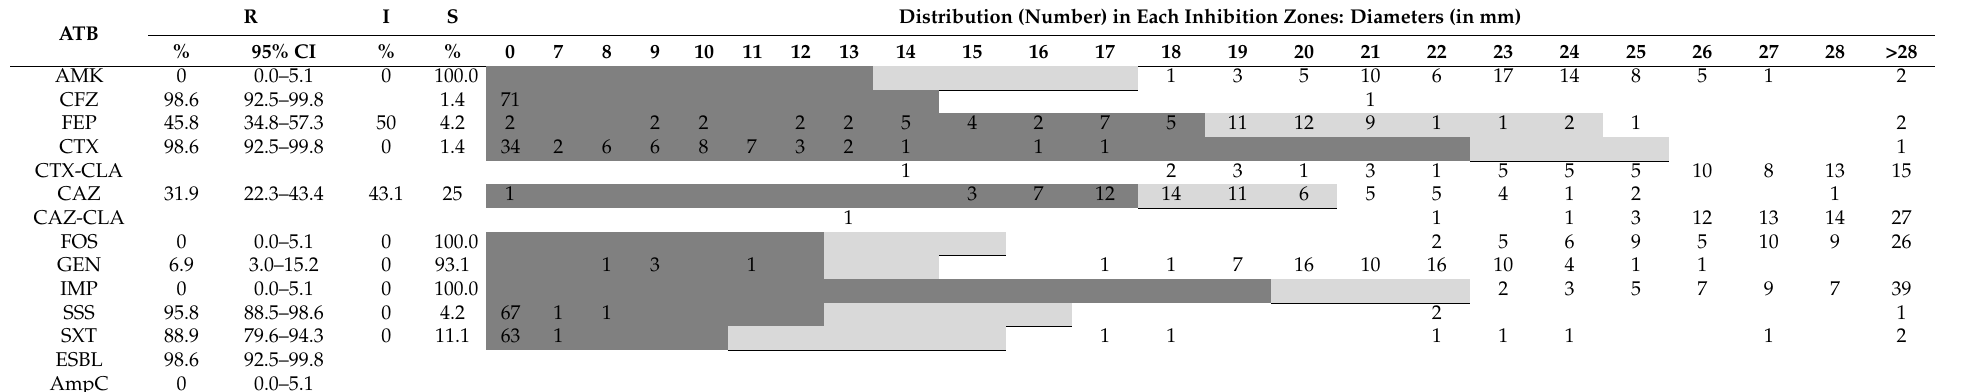
Table 5. Susceptibility to the second panel of antibiotics of all E. coli resistant to third-generation cephalosporins ( n = 72) from food animals in the East province of Rwanda. R I S Distribution (Number) in Each Inhibition Zones: Diameters (in mm) ATB